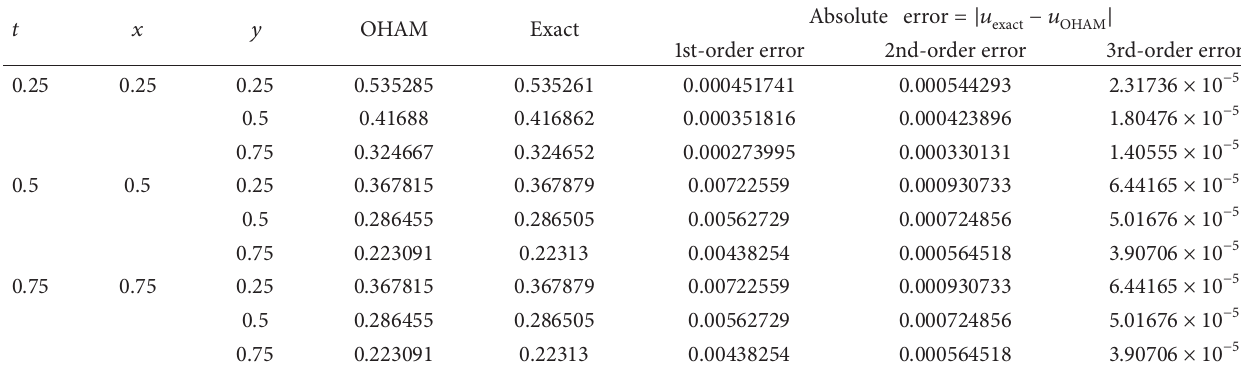
Table 2: Comparison of absolute errors of 𝑢(𝑥,𝑦, 𝑡) at different orders of approximation.